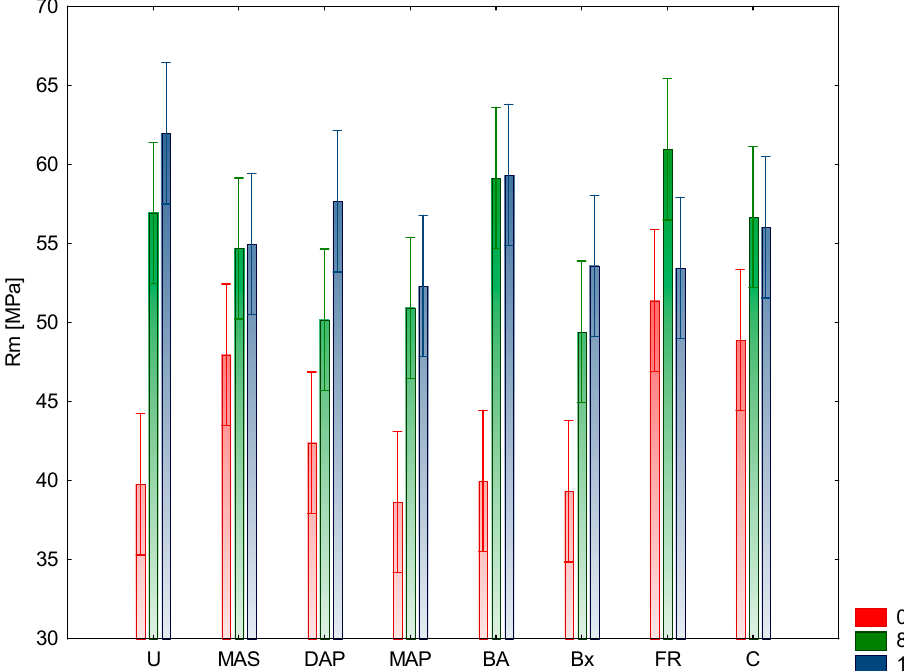
Figure 2. Illustration of the Rm relationship of aging cycles and chemical compounds. Whiskers represented 95% confidence